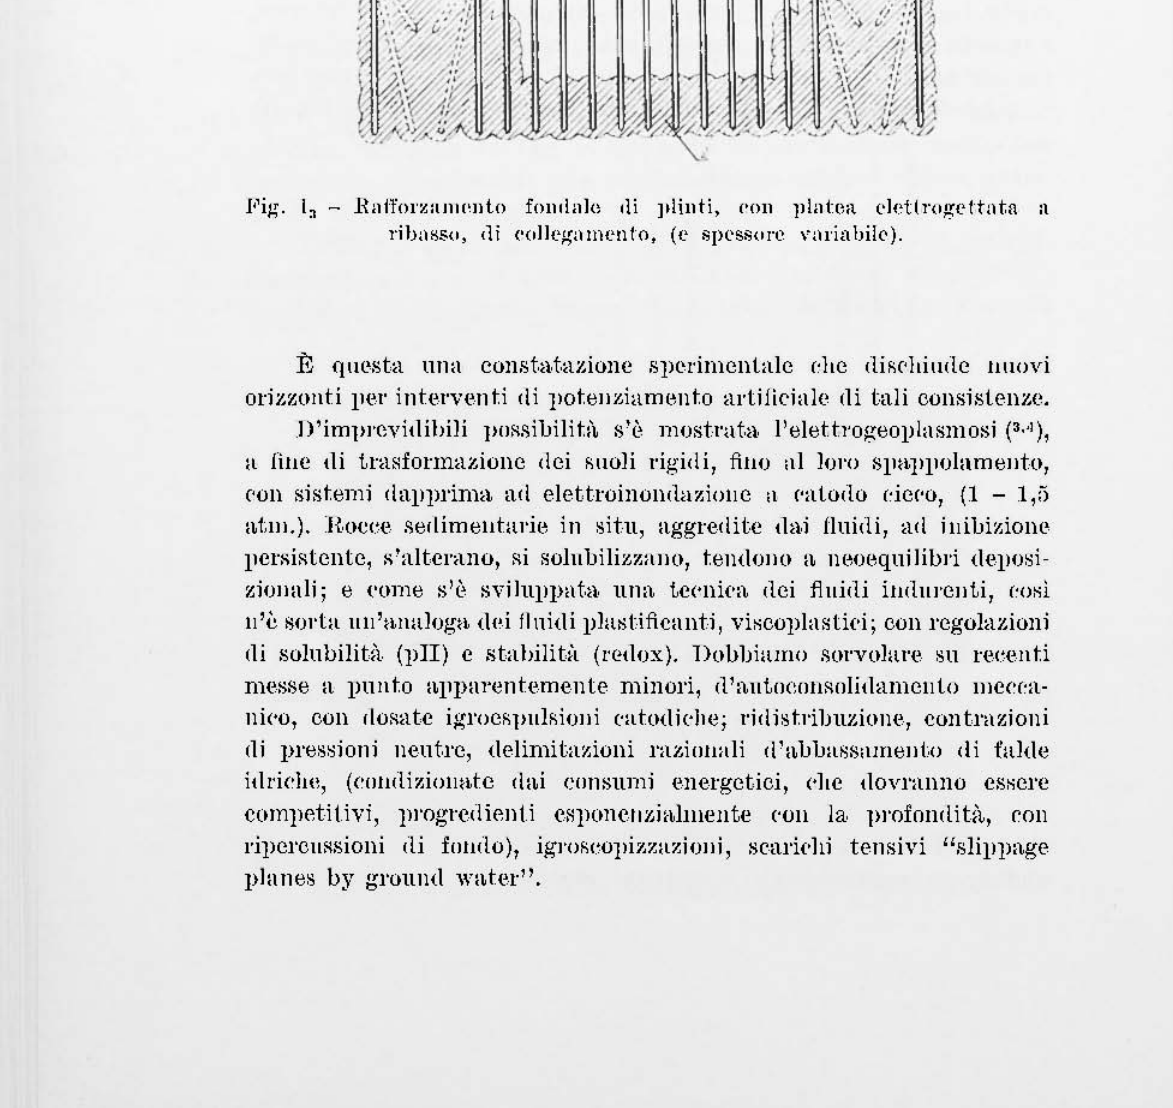
È questa una eonst.a,t.azione Sllt'rimentale (~lte (li~(·ltill(le jHloyi orizzonti per interventi di llotenlliamento artificiale (li t.ali consistenlle. D'impl'cvidibili I)(l~sibilih\ s'è mostrat.a, l'elettrogeoplasmosi (3"1), a fille di traHformazione dei woli rigidi, fillo ili lm'o SpallllOlamento, ('on sistemi dall}lrima ad elettroinon(la~iolle il C'atorlo (jec'o, (l - 1,:') atlll.). Hoeee sedimellbl1'il~ in situ, aggredit.e da,i fluirli, ad illibizionc persii'ltente, s'altenlllù, i'li solubilill~ano, tendono a neoequilibl'i dellosi zionali; e {'ome s'è svihlJlpat.a, U1m teeniea Ilei fluirli ilHlul'enti, (~o~ì Il'è smta ull'analoga dei flnidi plastifieanti, vi~co}llastiei; conregolallioni (li solubilità. (}l1I) e stabilitù (rt=dox). Dobhiamo sorvolare su reeenti messe a punto apparentemente minori, (l'autoc:olli'lolidamellto llle('(~a­ nieo, con dOi'late igroe~pul~ioni eatodi('he; ridisb'ilmllione, eontmzioni (li pressioni neut.re, delimit.azioni mziollali d'abba~Silment.o di falde idrie!w, (('()/I(li~iollate dai consumi energetici, elle dovranno es~ere COlll}lctitivi, }ll'Ogrcdicnti CH}lOnCtllIia.lmente C'OIl la, pl'OfOllllità., con l'i}lercui'lsioni rli f()/I(lo), igl'o~eollill~a~ioni, seariehi tensivi "s1ill!mge planes by gl'Ound